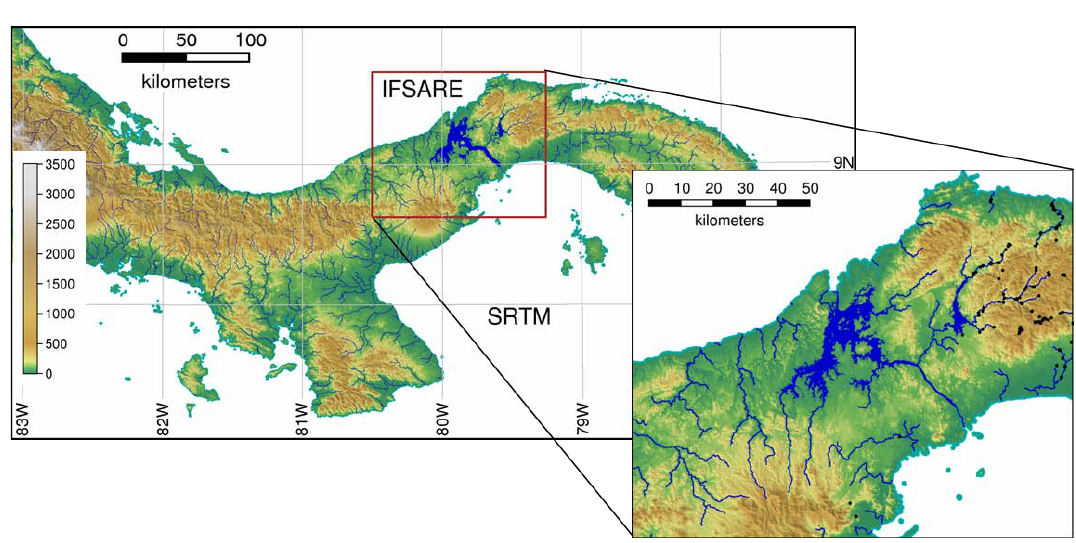
Fig. 2. SRTM and IFSARE coverage of Panama. GPS ground control points are displayed in